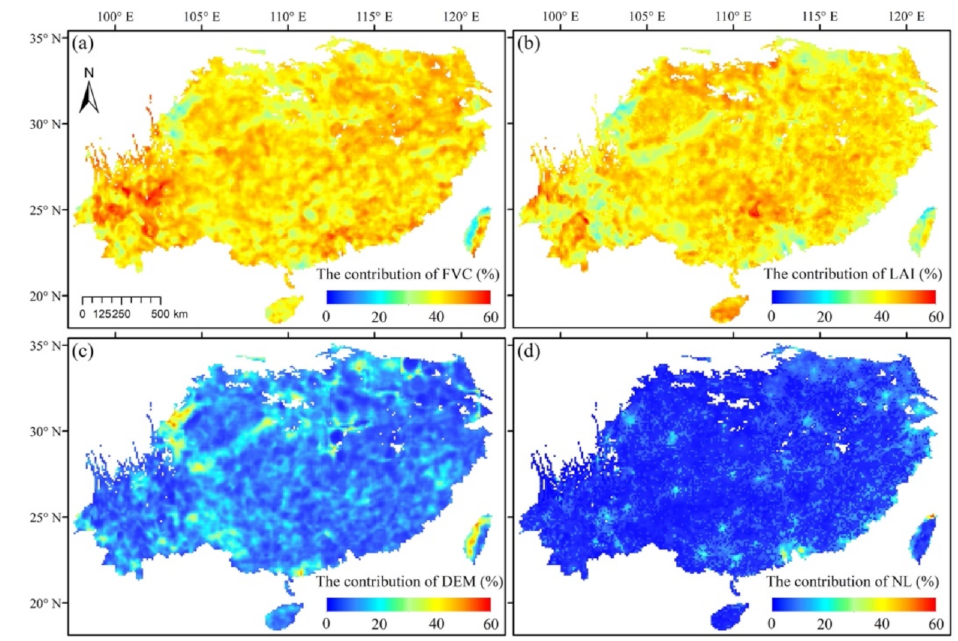
Figure 10. The relative contributions of four land surfaces to the LST downscaling in the GTWR process presented by the Pratt index (transformed to percentage). ( a ) FVC: fraction of vegetation coverage; ( b ) LAI: leaf area index; ( c ) DEM: digital elevation model; ( d ) NL: nighttime